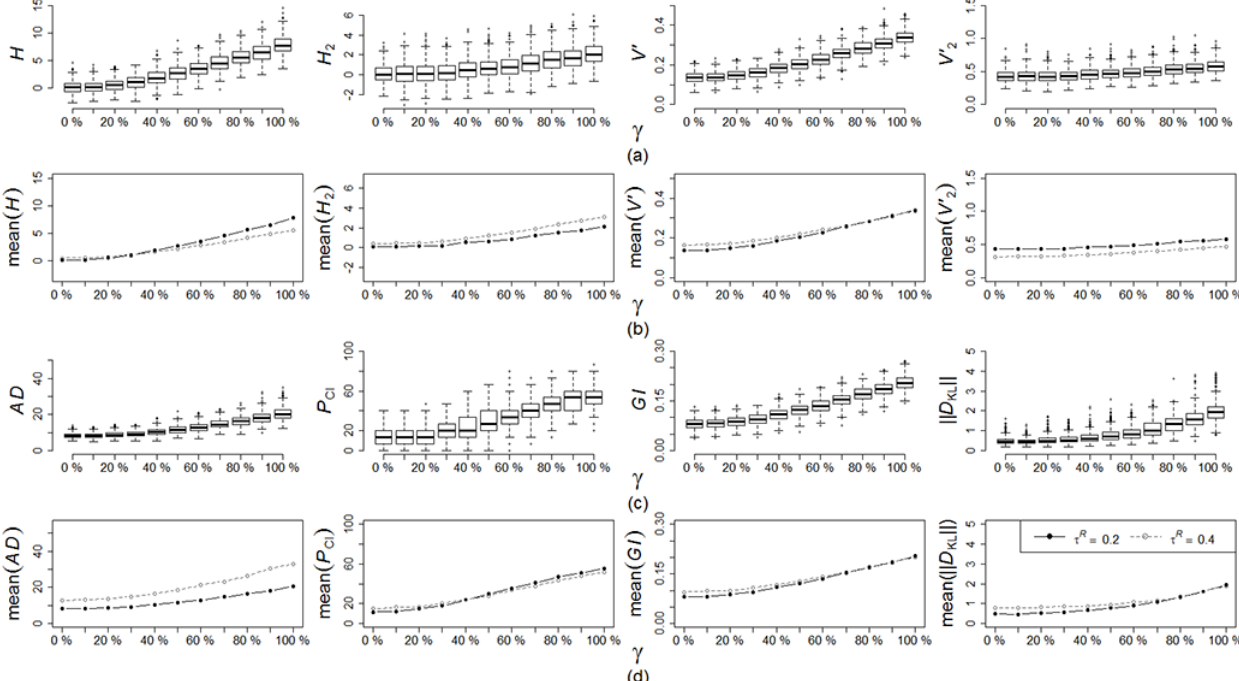
Figure 1. Sensitivity analysis: (a, c) box plots of the heterogeneity measures for N s = 500 simulations of the reference region ( N = 15, n = 30 and τ R = 0.2) varying the heterogeneity rate γ ; and (b, d) comparison of the corresponding mean with the one obtained by considering τ R =